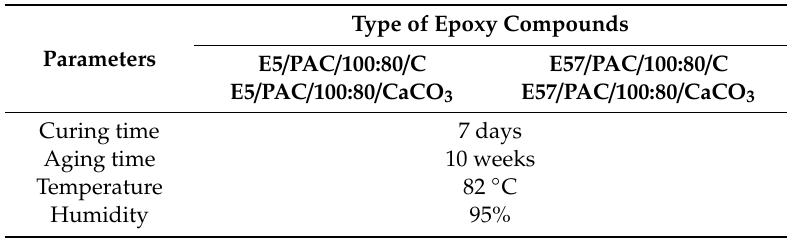
Table 4. Aging conditions of the epoxy specimens in the climate chamber.